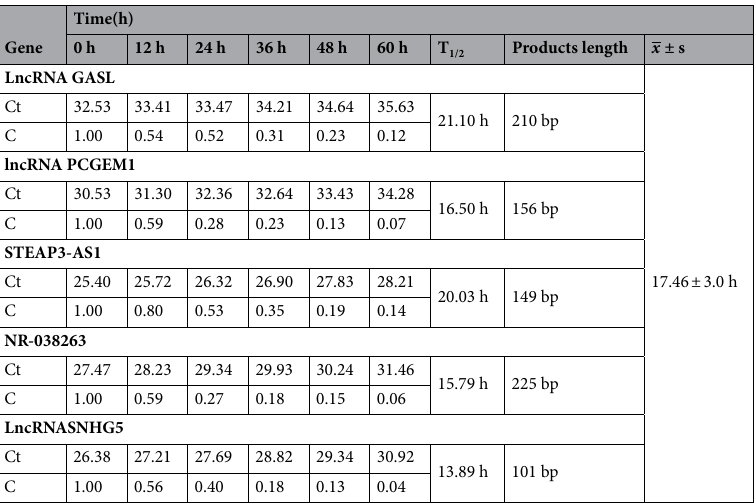
Table 7. Changes in lncRNAs concentration in whole blood at room temperature. The 95% confidence interval for T 1/2 was calculated to be (14.830, 20.090).